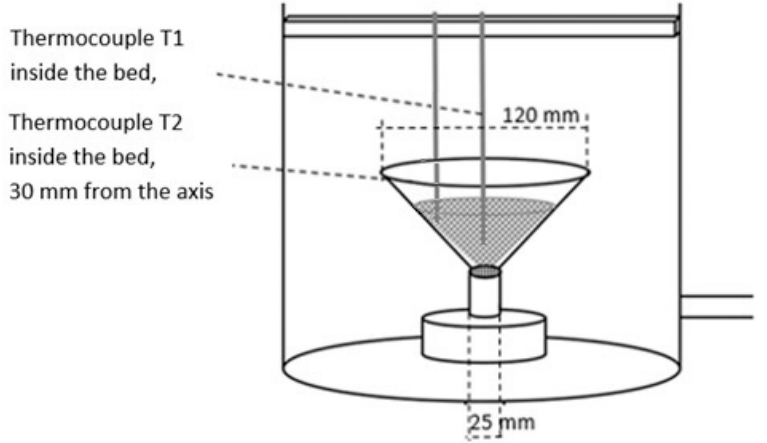
Figure 4. The equipment of the adsorption